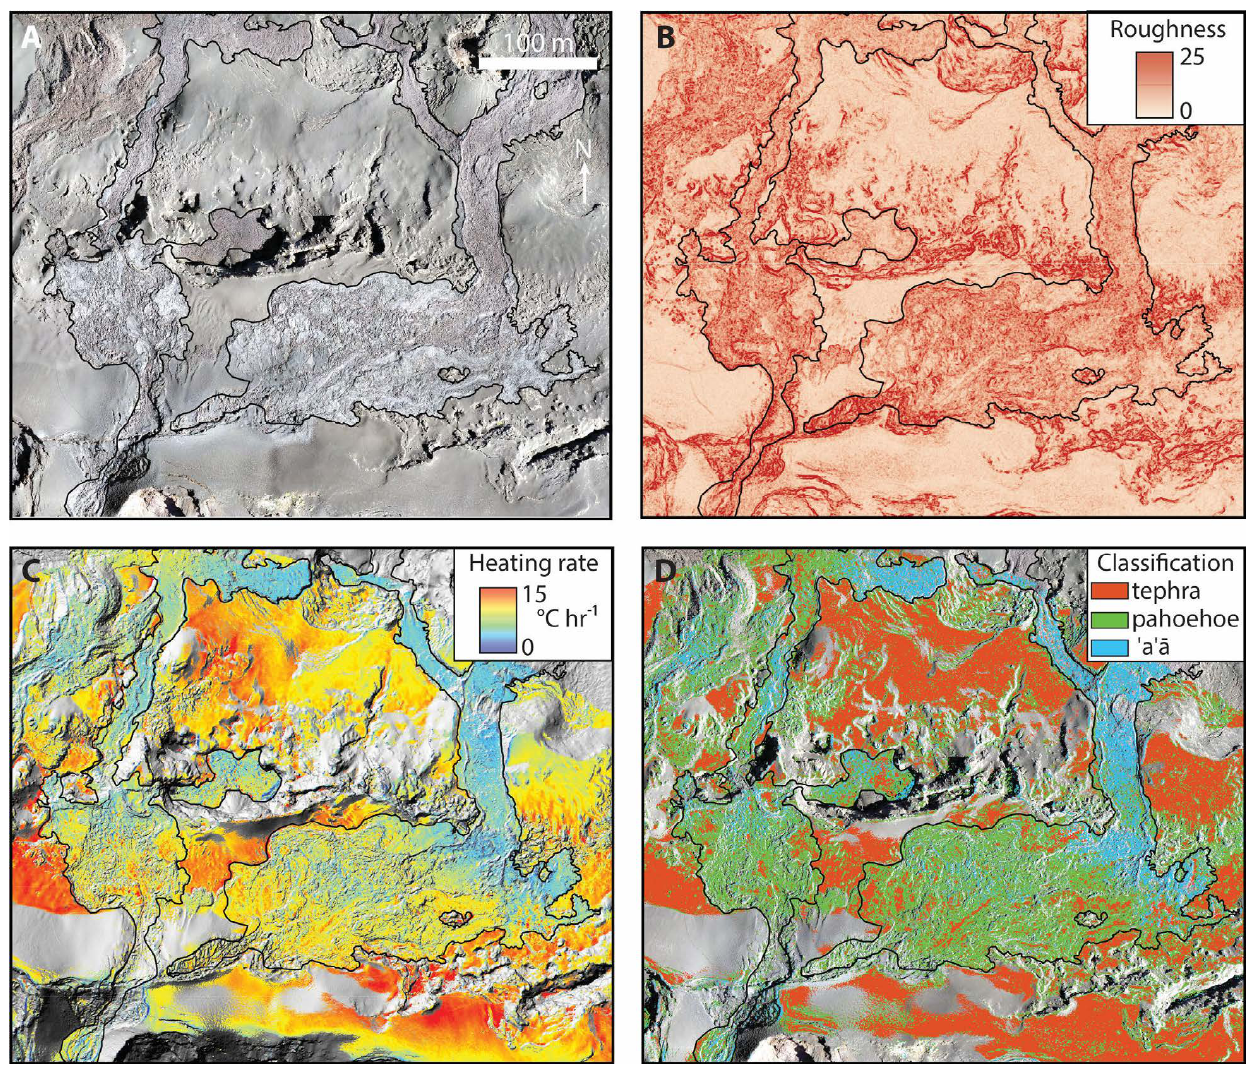
Figure 6: Remote classification of lava flow surface morphology using decimetric-resolution UAS data from Sierra Negra (Isla Isabela), Galapagos, Ecuador [Carr et al. 2019]. [A] A true-colour orthomosaic of a recent lava flow with both p¯ahoehoe and ‘a‘¯a morphologies, as well as tephra deposits. [B] Surface roughness (calculated as the standard deviation of DEM slopes in a 5 × 5-cell (1 m 2 ) moving window) and [C] the heating rate, derived from repeat thermal surveys, were used to identify typical values for each surface cover type and, hence, [D] remotely classify the distributions of eruption